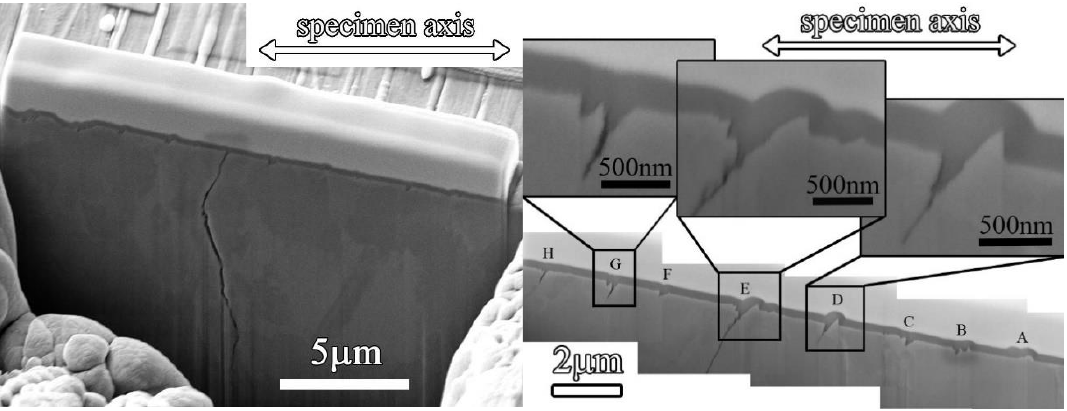
Figure 14. FIB cut of the grain of fatigued 316L steel and the details showing crack initiation from intrusions.